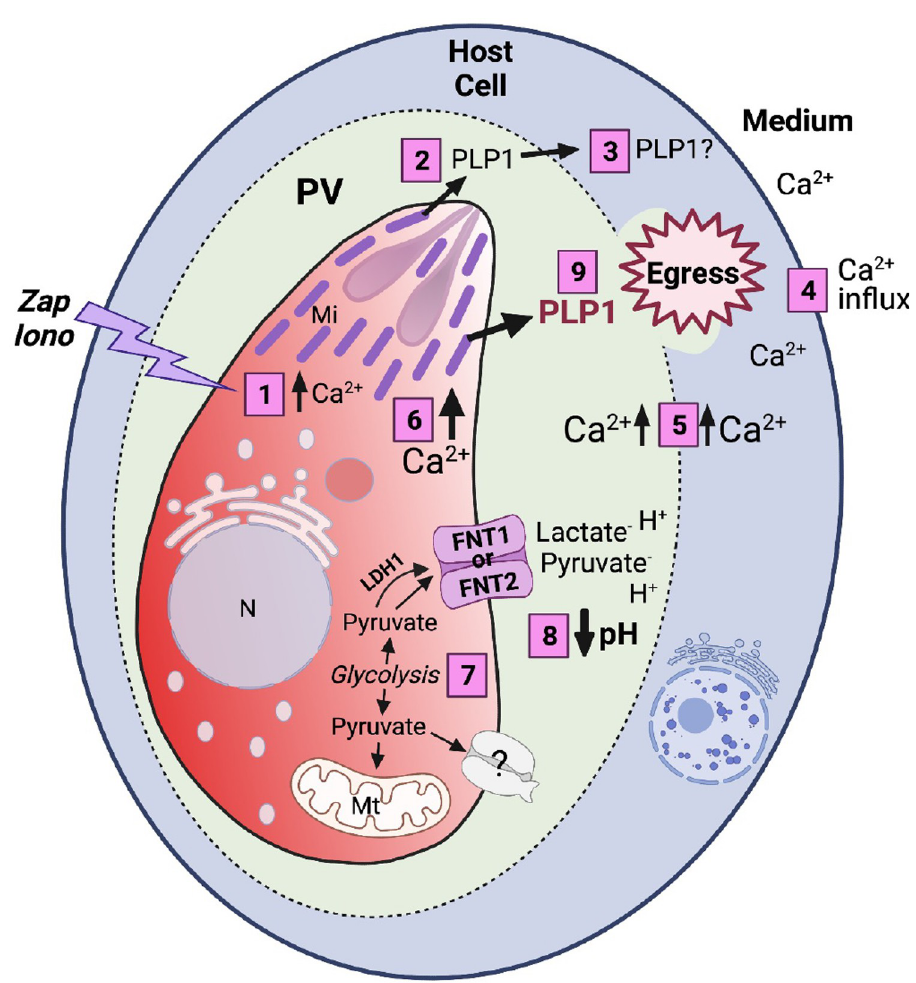
(2) to form pores in the PV membrane and possibly host cell membrane. This allows an influx of ions such as Ca 2+ (4) into the host cell, into the PV (5), and potentiates another increase in the parasite (6), which results in